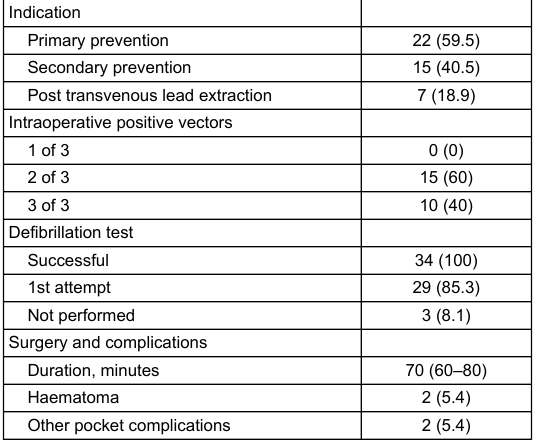
Table 2: Implantation data.